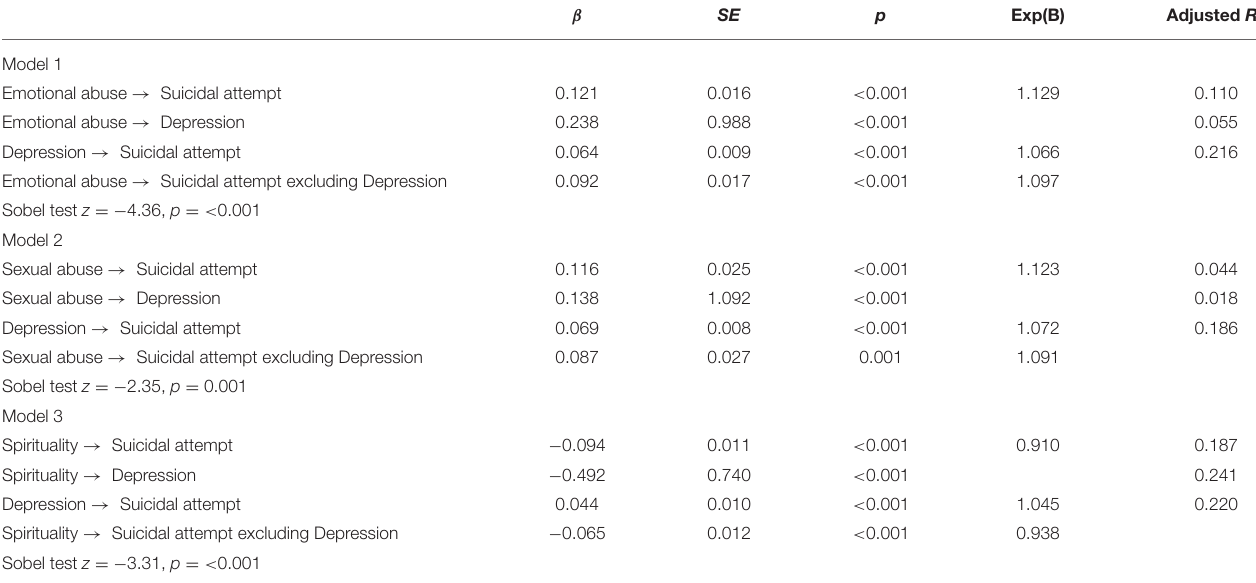
TABLE 3 | Mediating effects of depression on patients’ suicide